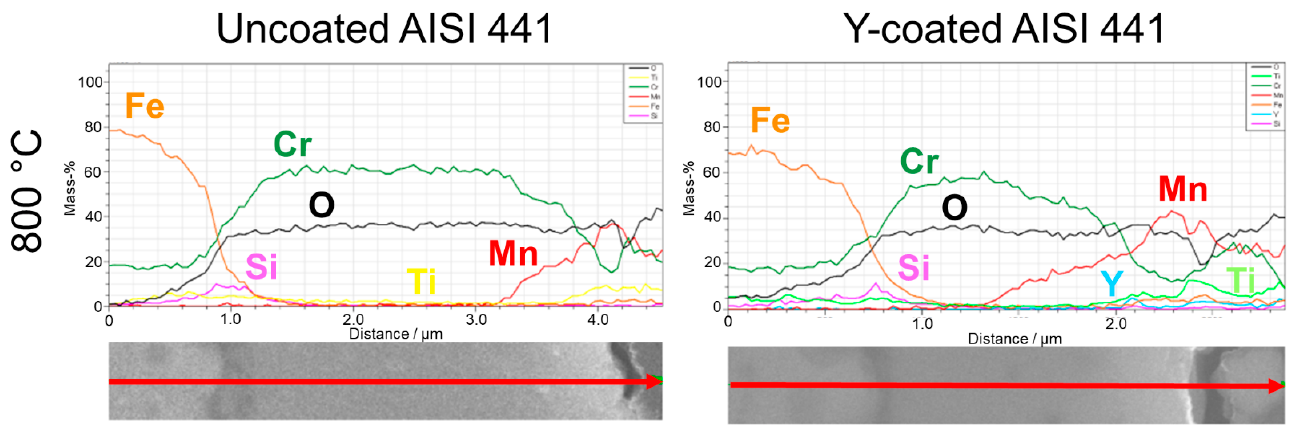
Figure 15. EDS line scans of uncoated AISI 441 ( left ) and Y-coated AISI 441 ( right ) after 1500 h at 800 °C in reducing atmosphere. The red lines (also marked in Figure 14) indicate the location of each profile.